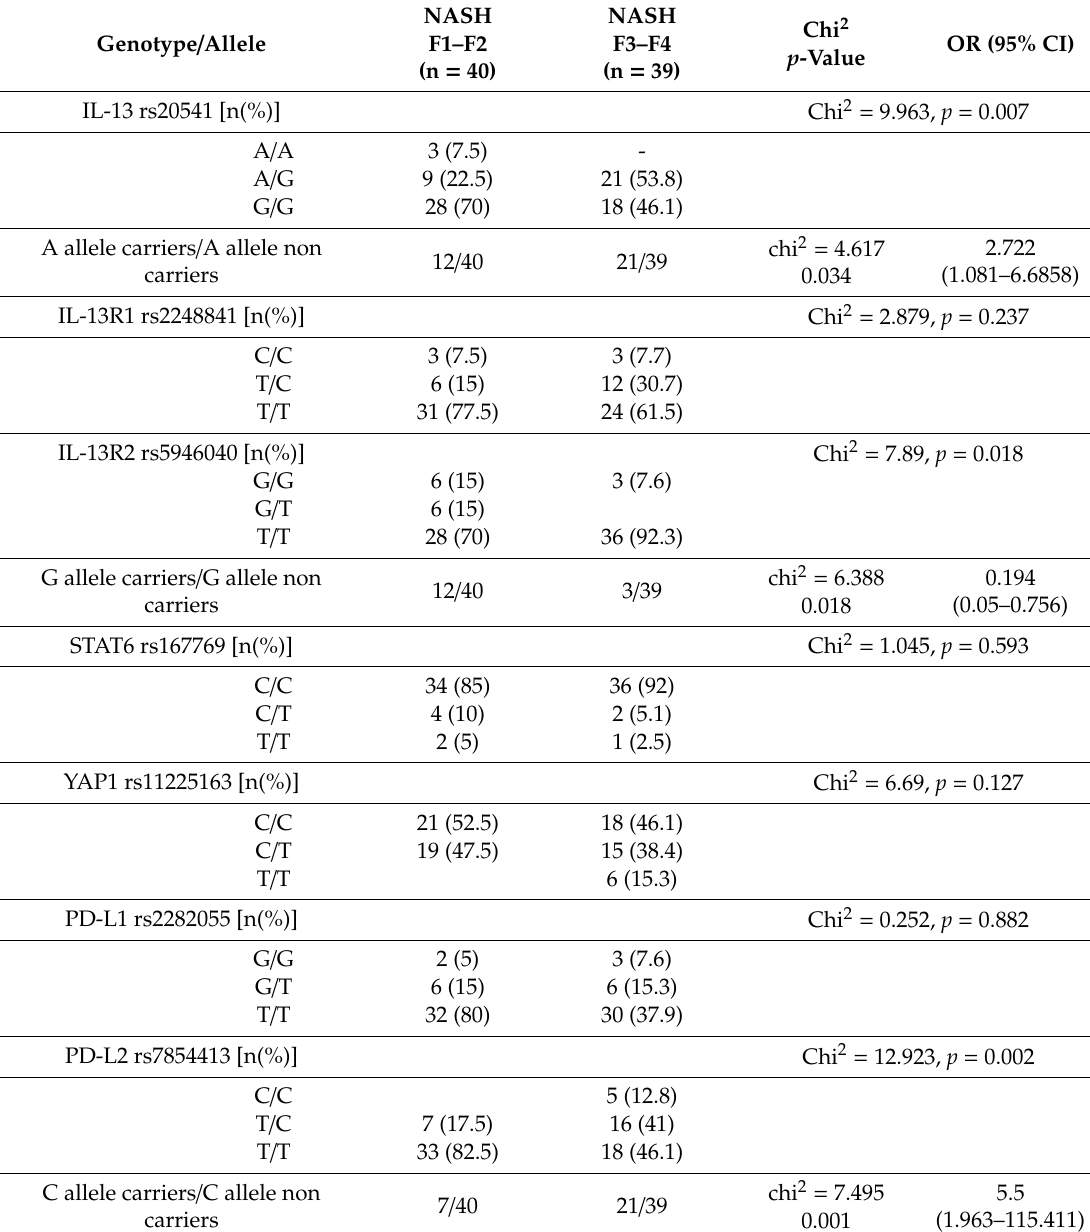
Table 4. Association of gene polymorphisms with advanced fibrosis grades in NASH